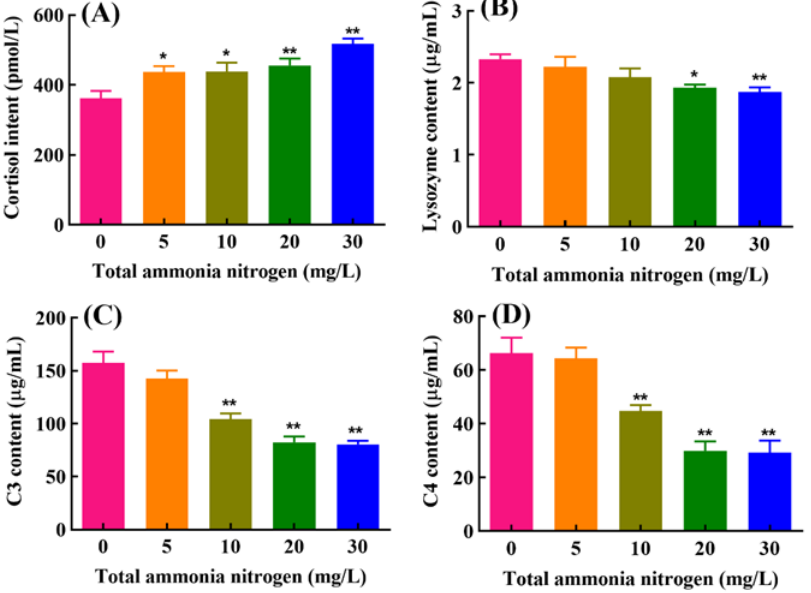
Figure 2. Effects of chronic ammonia exposure on levels of serum cortisol, lysozyme, C3 and C4 ( A – D ) in M. amblycephala . Each column represents mean ± SE of six duplicates. The values of p < 0.05 and 0.01 are represented as “*” and “**” above the column, indicating significant difference versus control, respectively.